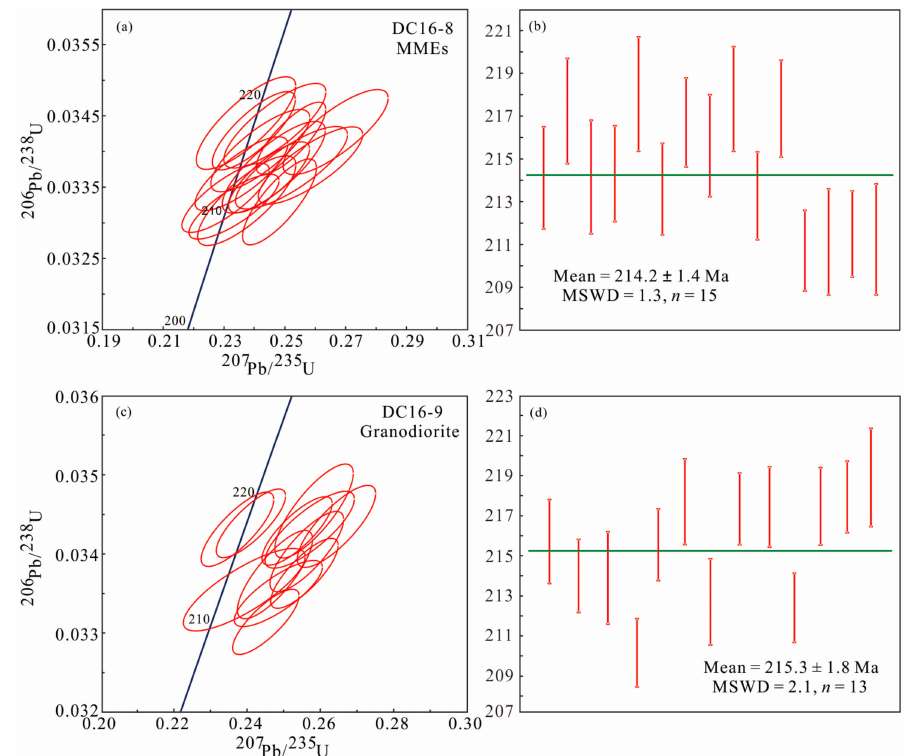
Figure 7. LA–ICP–MS zircon U − Pb concordia diagrams for granodiorite and MMEs. ( a ) concordia age for MMEs; ( b ) weighted age for MMEs; ( c ) concordia age for granodiorite and ( d ) weighted age for granodiorite.